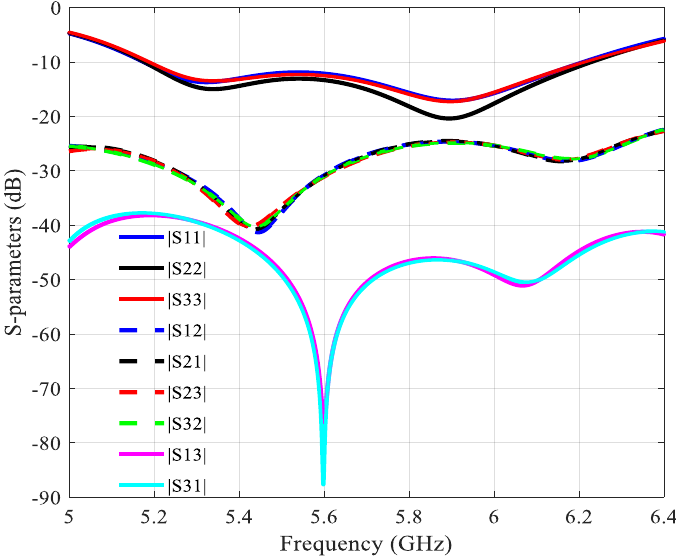
Figure 21. Simulated S-parameters of the 2 × 6 array with 3 ports.